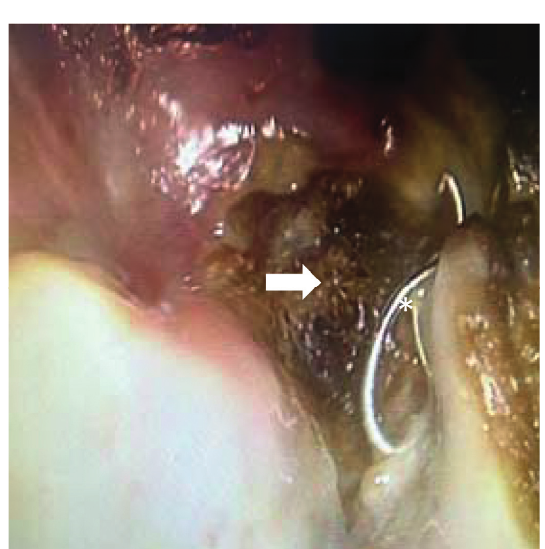
Figure 2: Endoscopic nasopharyngeal view showing the left necrotic lateral area with the dislocated coil ( ∗ coil, white arrow: necrotic